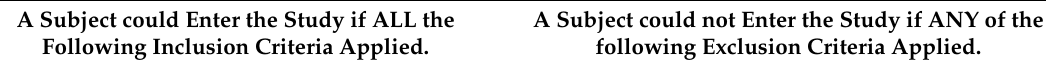
Table 1. Participation criteria for older adults. Inclusion criteria (left) and exclusion criteria